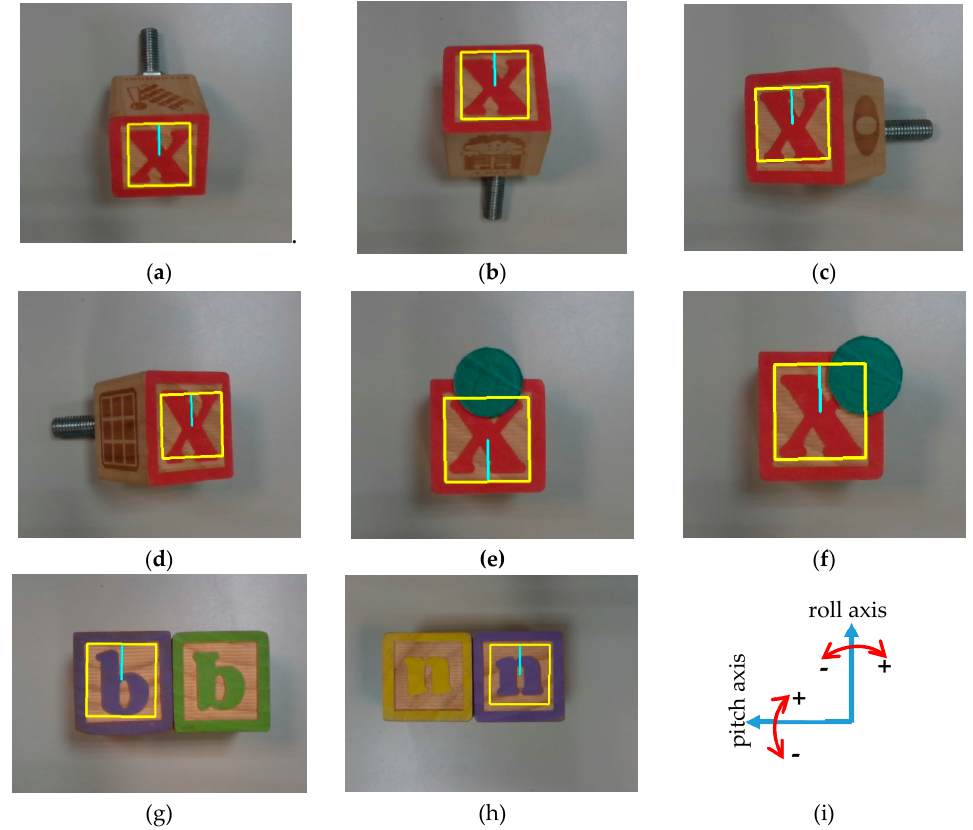
Figure 13. Matching results for the alphabet blocks dataset with the different perspective and occluded conditions: (a) and (b) show a description of the images with pitch angles of − 30 and +30 degrees, respectively; (c) and (d) show a description of the images with roll angles of − 30 and +30 degrees, respectively; (e) and (f) show a description of the occluded images; (g) and (h) show a description of the easily confused images, in which the former shows that the target “b” was matched correctly, while the object “inverted-q” was an easily confused object with target “b”. The same for the target “n” and the easily confused object “inverted-u” in (h); (i) illustrates the direction of pitch and roll axes. All the images have a resolution of 1280 × 720 pixels.